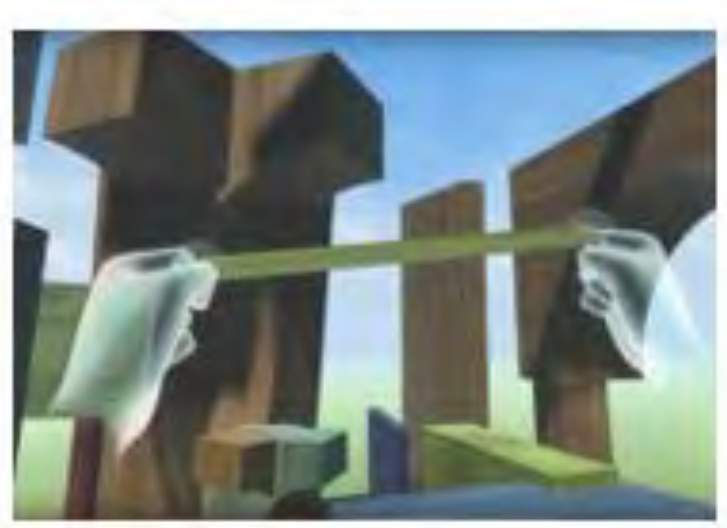
Figure 1. Screenshots of the Kitoparts design tool running on Oculus Rift using Oculus Touch controllers.